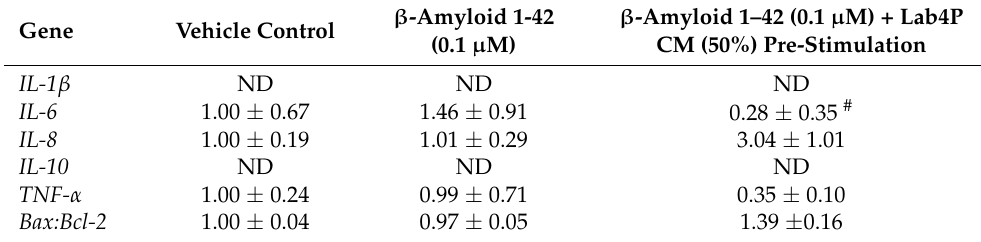
Table 3. Fold change in mRNA expression in differentiated SH-SY5Y cells exposed to β -Amyloid 1-42 (0.1 µ M) for 48 h, with or without pre-stimulation with Lab4P CM (50%) for 24 h. mRNA expression is presented as a mean fold change ± standard error of the mean (SEM) of four ( IL-6 and IL-8 ) or three ( TNF- α and Bax / Bcl-2 ) independent experiments compared to the vehicle control that has been arbitrarily set as 1. ND: mRNA expression not detected. Values of p were determined using one-way ANOVA with Kruskal–Wallis test with Dunn’s post-hoc analysis or Brown–Forsythe ANOVA with Dunnett’s T3 post hoc analysis where # p < 0.05 compared to the vehicle control. Abbreviations: IL , interleukin; TNF- α , tumour necrosis factor- α ; Bcl-2 , B-cell lymphoma 2 gene; Bax , Bcl-2 -associated X apoptosis